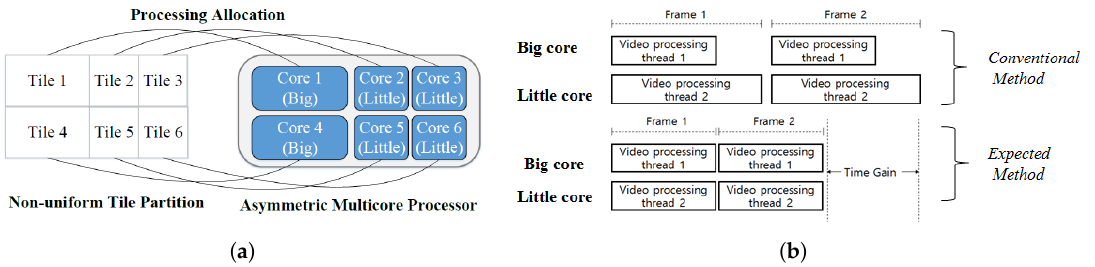
Figure 2. Non-uniform tile partition with ( a ) the concept of tile partition based on Asymmetric Multicore Processor, ( b ) Expected decoding time gain of non-uniform tile